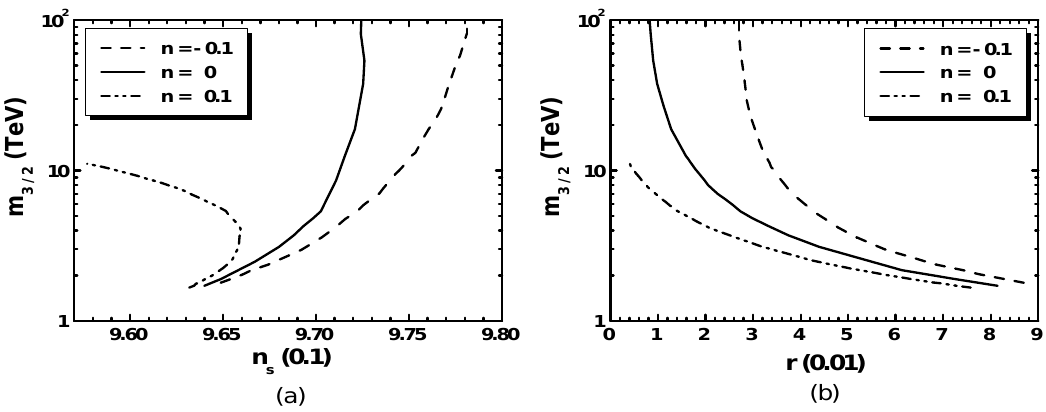
F IGURE 3 : Thegravitinomass m 3 / 2 versus n s (a) or r (b) for µ = 1 TeV , λ µ = 10 − 6 , a 3 / 2 = 1 , K = K 2 or Figure 3. The gravitino mass m 3/2 versus n s ( a ) or r ( b ) for µ = 1 TeV, λ µ = 10 − 6 , a 3/2 = 1, K = K 2 or K 3 with N X = 2 and n = 0 . 1 (dot-dashedline), n = 0 (solidline),or n = +0 . 1 (dashedline). K 3 with N X = 2 and n = 0.1 (dot-dashed line), n = 0 (solid line), or n = + 0.1 (dashed − −